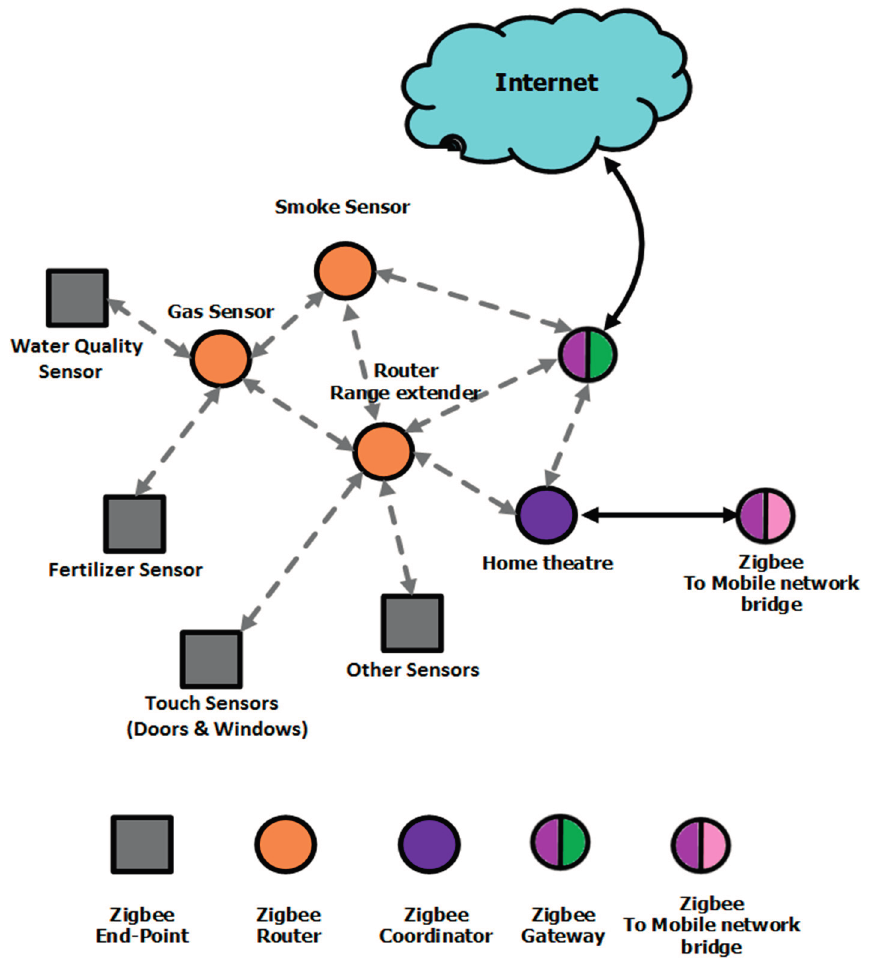
Figure 1. Network Architecture for smart homes [3] using a ZigBee platform that can be adapted to the connectivity of DIS and EIS sensor devices, such as water quality sensors, fertilizer sensors, and touch